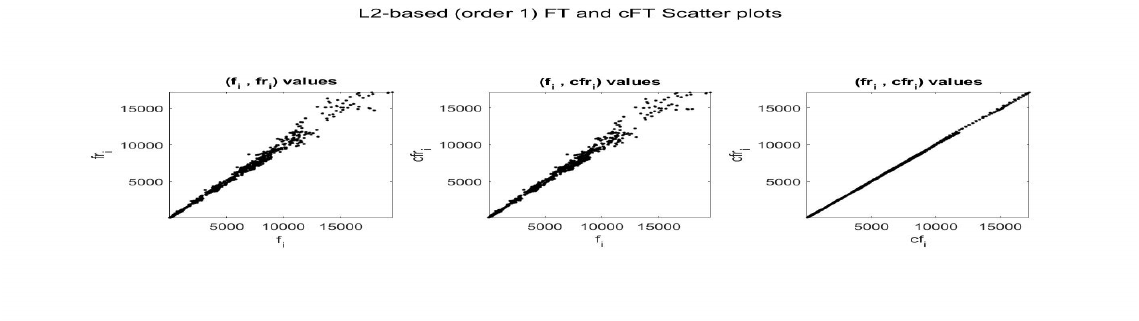
( t ) and f q ( t ) using L 2 -norm F-transform j j ( P b , A , r ) c , ( P b , A , r )